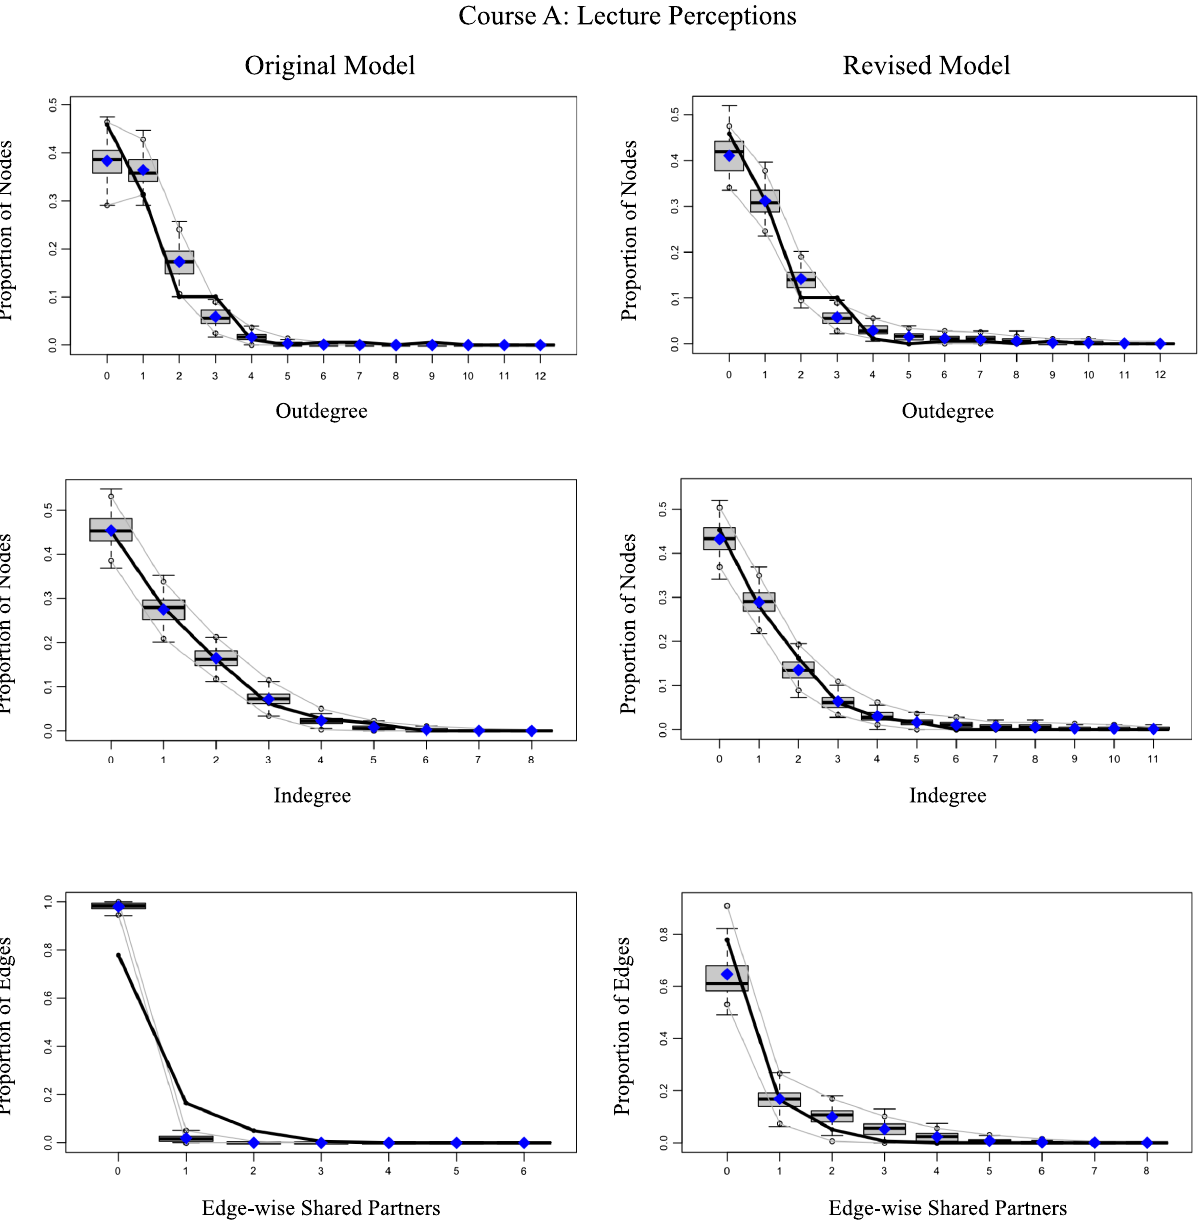
FIG. 5. Goodness-of-fit diagnostics for both the original ERGM model [30] and the revised ERGM model for the lecture perception network of Course